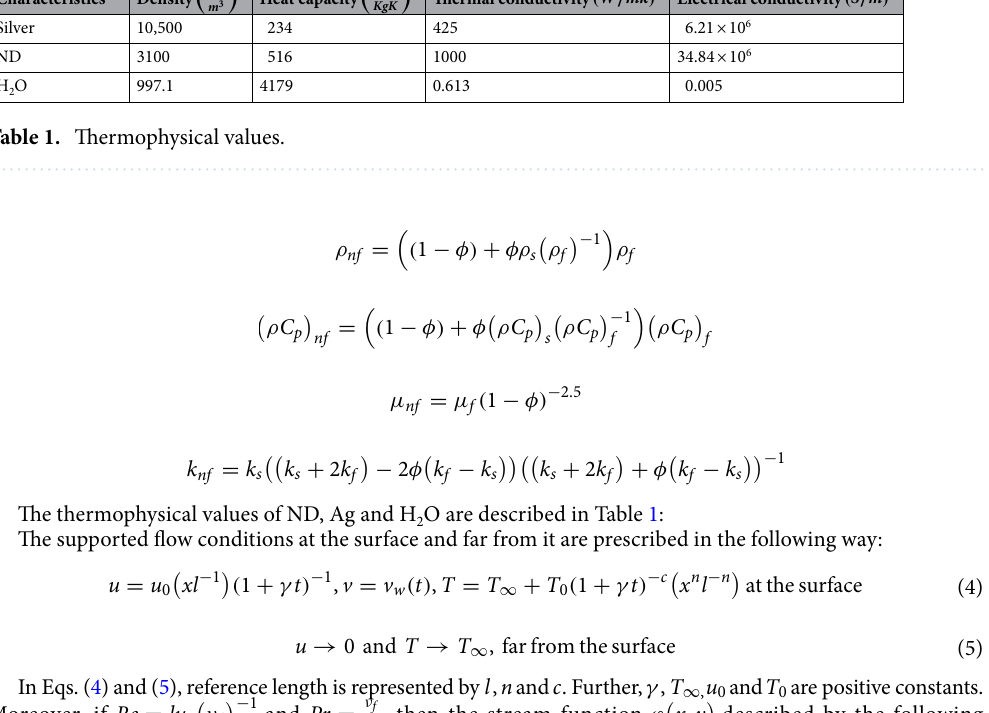
Table 1. Thermophysical values.